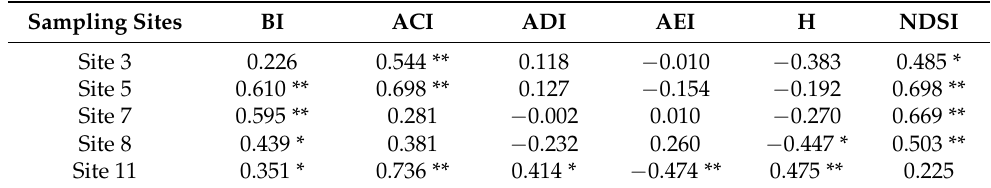
Table 4. The Spearman rank correlation coefficient between acoustic indices and avian species richness at each sampling